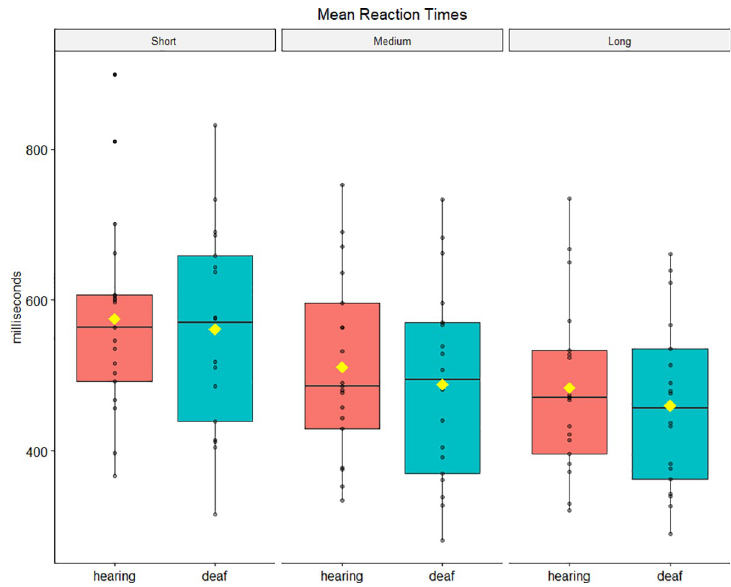
Fig 2. Mean reaction times per SOA condition. Fig 2 was created using the ggpubr package in R [46]. Horizontal lines indicate medians; yellow rhombuses indicate means.